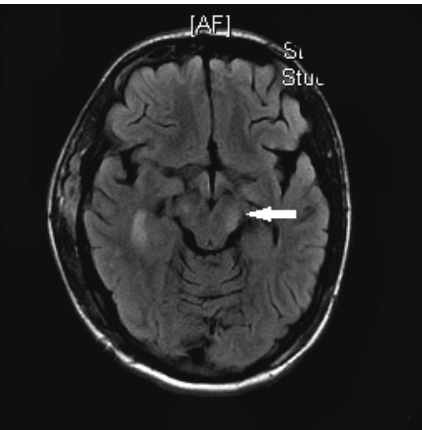
Figure 4: Postop MR demonstrating contralateral (left) cerebral crus infarct from herniation (Kernohan’s notch phenomenon).